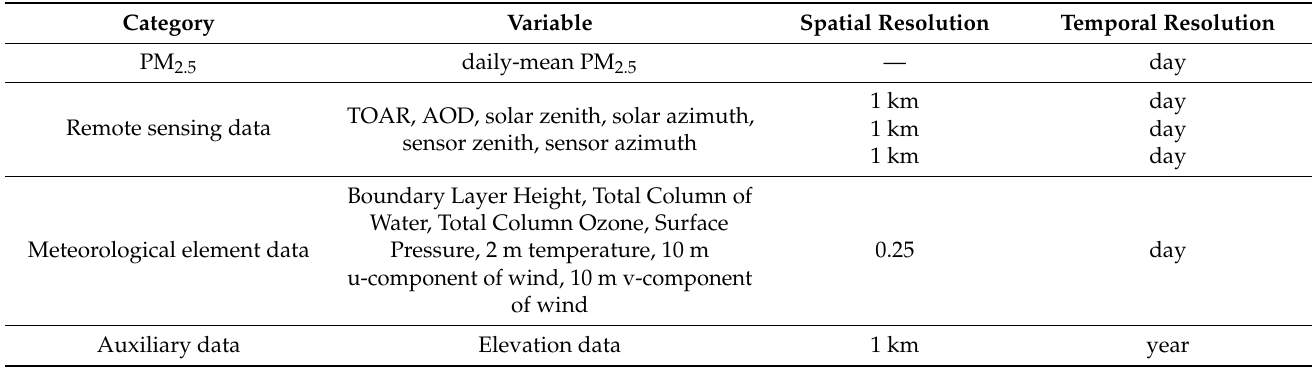
Table 1. Descriptive statistics of the